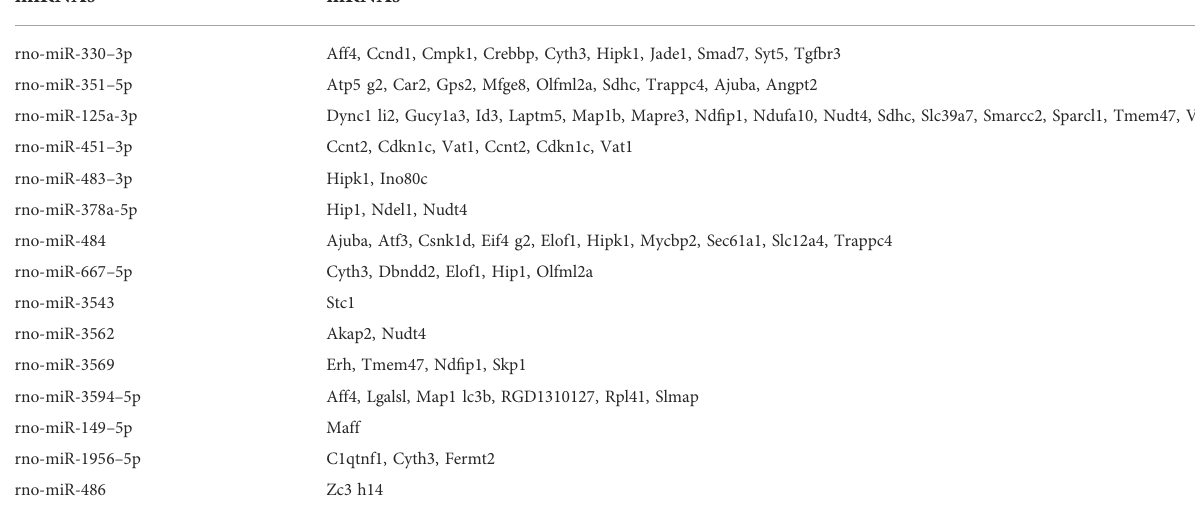
TABLE 2 The miRNAs with their respective target mRNAs in the ceRNA network. miRNAs mRNAs